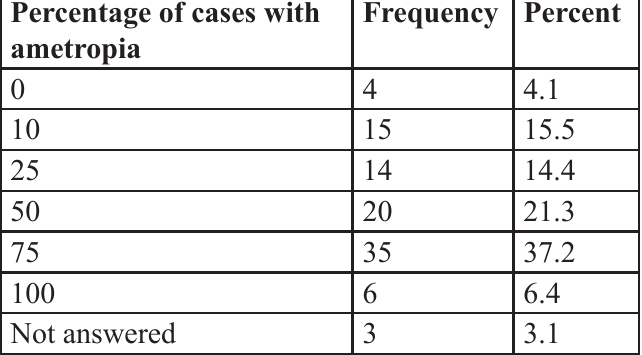
Table 3: Percentage of cases with